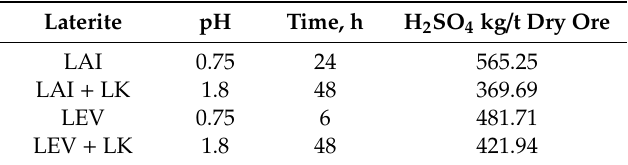
Table 8. Cumulative acid consumptions (H 2 SO 4 kg / t dry ore) from H 2 SO 4 leaching of LAI (24 h) and LEV (6 h) laterites under the following conditions: pH 0.75, 90 ◦ C, S / L = 30%, followed by LK addition to increase pH to 1.8 (until 48